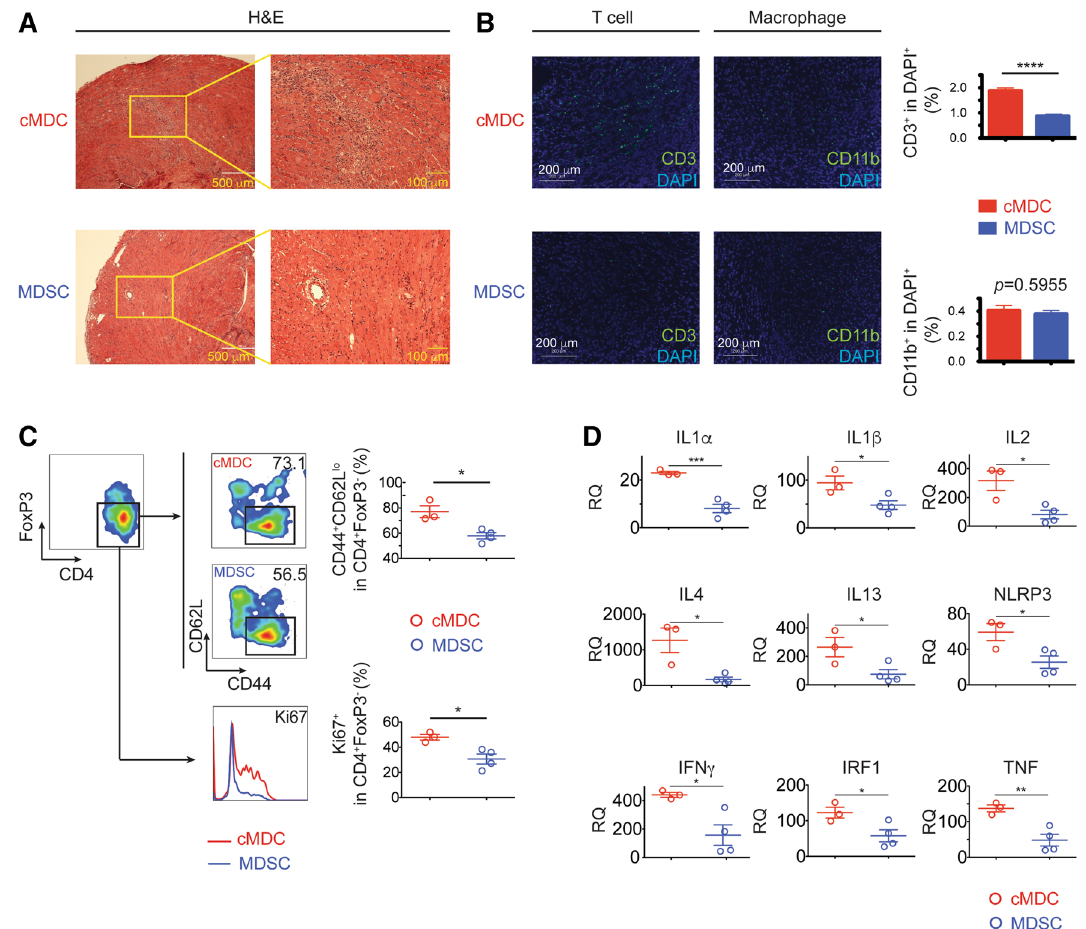
Figure 2. Allografts from donor-derived MDSCs treated recipients exhibit ameliorated T cell mediated inflammation and increased recipient-derived endogenous MDSCs. ( A ) Representative example of the allograft histology (H&E staining) from the MDSCs treated group and the cMDCs treated control on POD7. Scale bar represent 500 μm (left) and 100 μm (right). Data represents the one of 3 separate experiments. ( B ) Allografts were harvested on POD7 and stained with anti-CD3, anti-CD11b (green) and DAPI (blue). Scale bars represent 200 μm. Positive cells were qualitied by ImageJ and expressed as mean ± SEM. ****p < 0.0001, two-tailed unpaired t test. ( C ) Flow cytometry analysis of BALB/c MDSCs treated C57BL/6 recipients’ graft infiltration lymphocytes (GILs) on POD7. Graphs showing significant decrease of the proportion of CD44 + CD62L lo and Ki67 + in CD4 + FoxP3 - T cells in the MDSCs treated group. ( D ) qRT-PCR analysis of allografts (whole tissues) on POD3 (n = 3 per group). Graph represented as RQ (relative quantification) = 2 -ΔΔCt . Naïve BALB/c heart serve